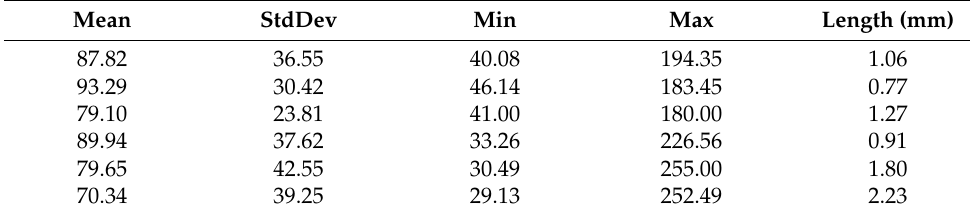
Table 2. Length measurements of SL-CNTs from ImageJ analysis.